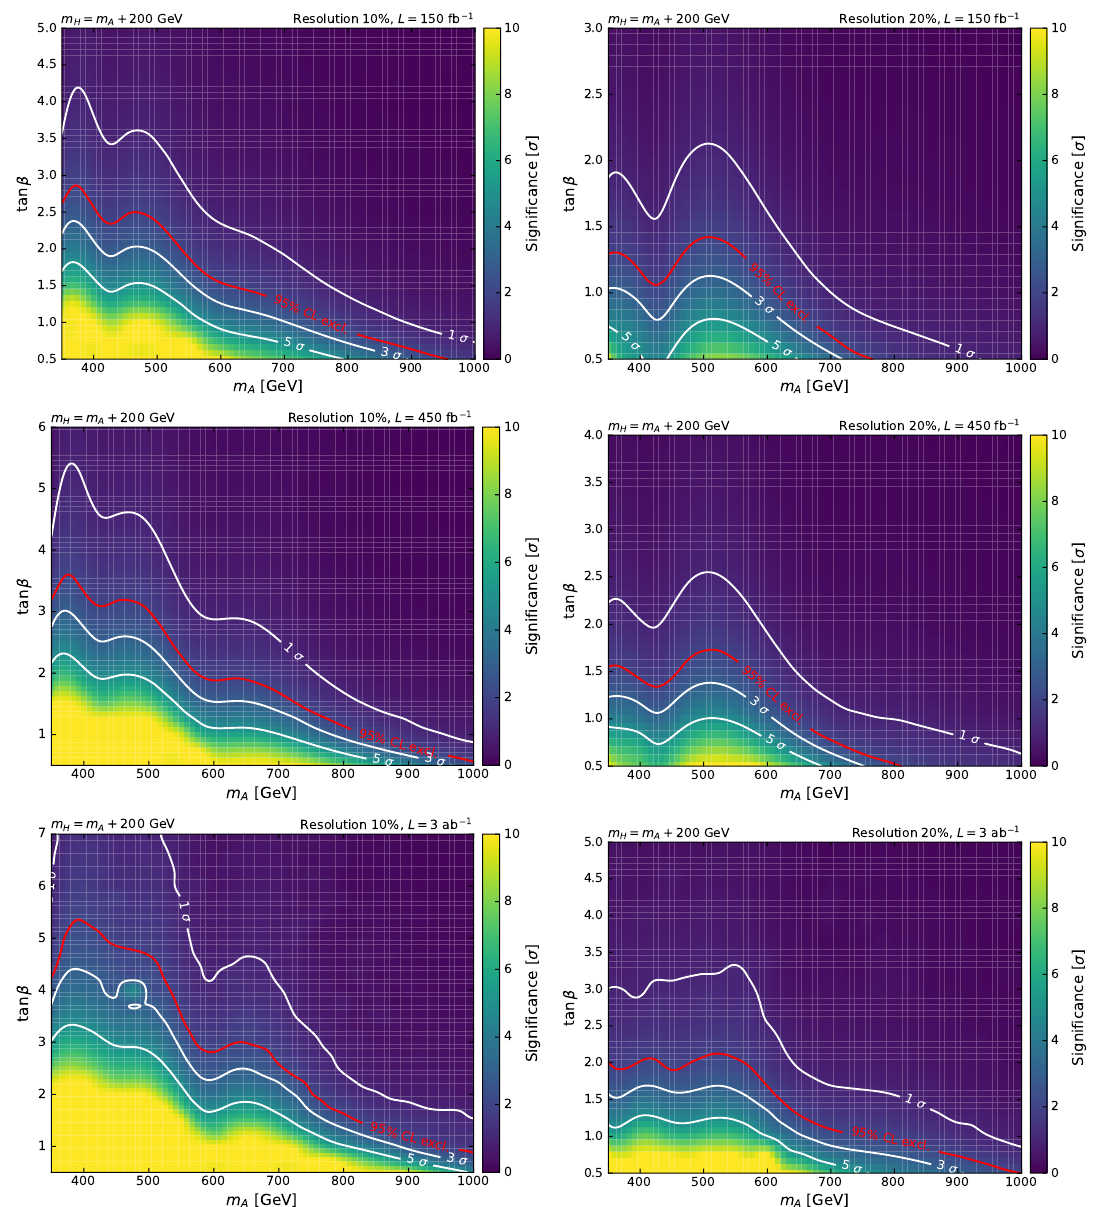
Figure 15 . Expected signi(cid:12)cance and exclusion potential for a Type II 2HDM with a mass splitting M H (cid:0) M A = 200 GeV in the same six experimental scenarios as considered in (cid:12)gure 10. Values of signi(cid:12)cance in excess of 10 (cid:27) are clipped. A resolution of 10% and 20% is assumed for the left- and the right-hand side plots,